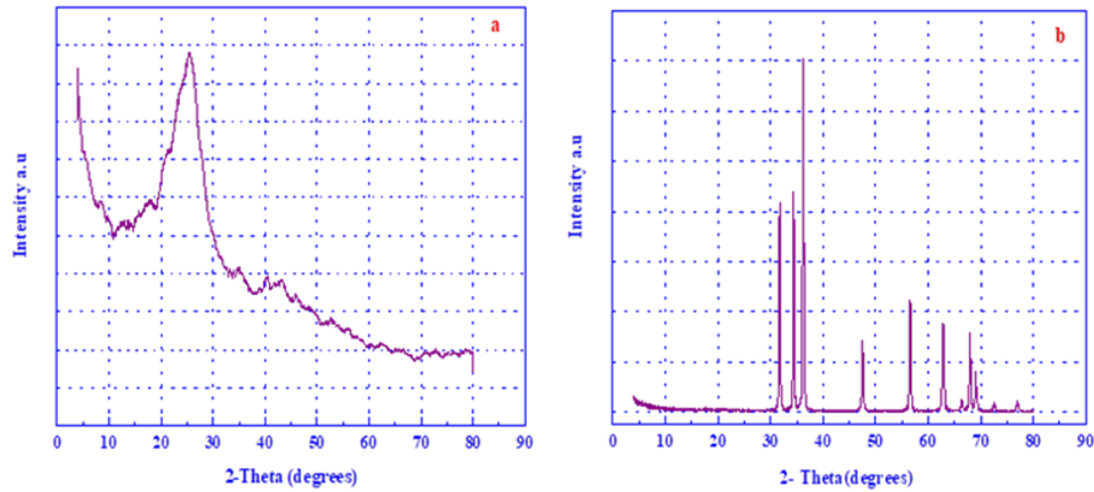
Figure 1. XRD diffractogram of synthesized ( a ) Fe-AC; ( b ) ZnO-NPs samples.